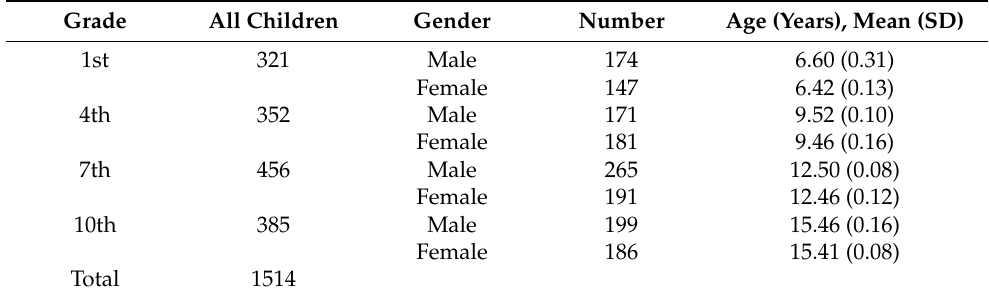
Table 1. Distribution of the schoolchildren by gender according to the grade they attended at the first measurement.